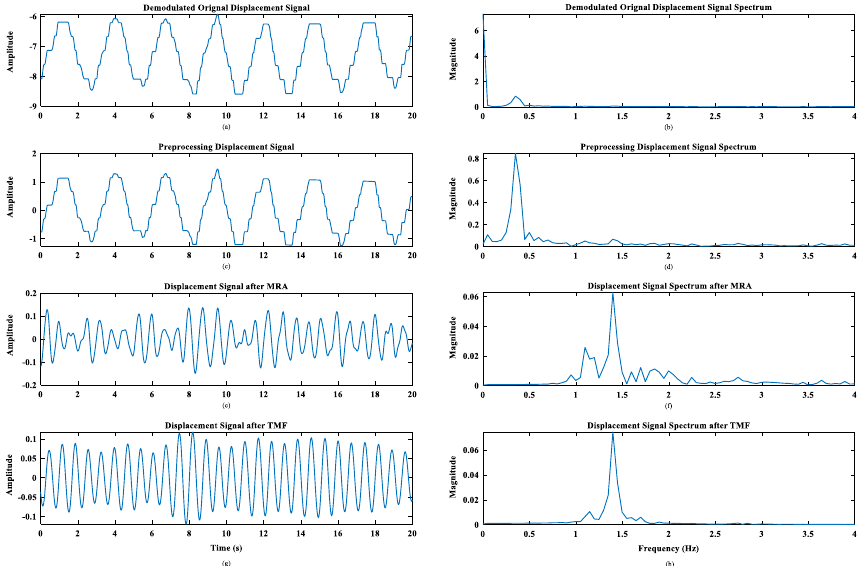
Fig. 4 A contrast of the chest-wall displacement waveforms and corresponding